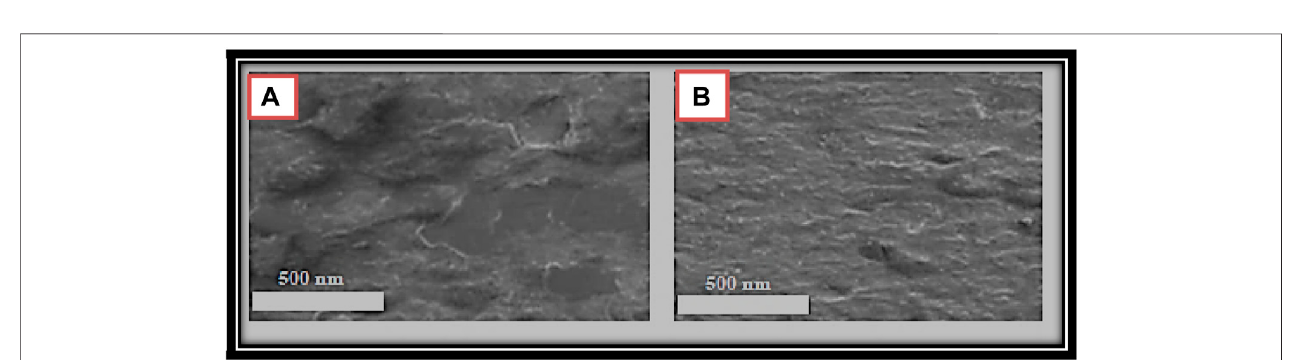
FIGURE 8 | Effect of toxicity of different concentrations of nano fi bers on cells with MTT